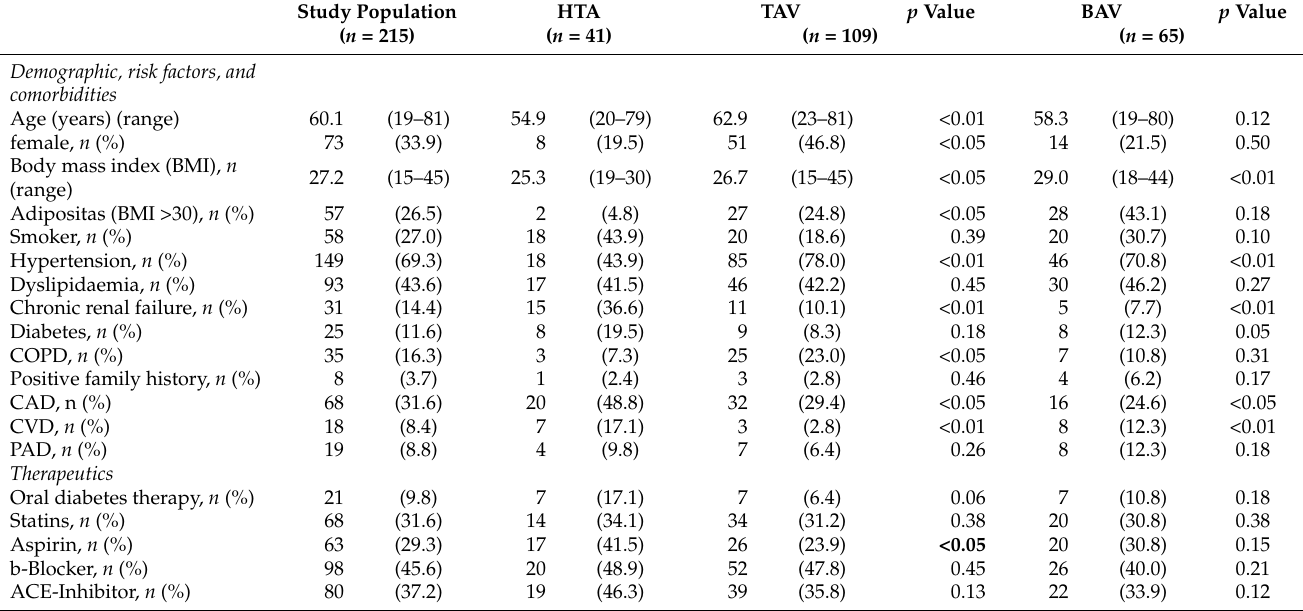
Table 1. Patient baseline